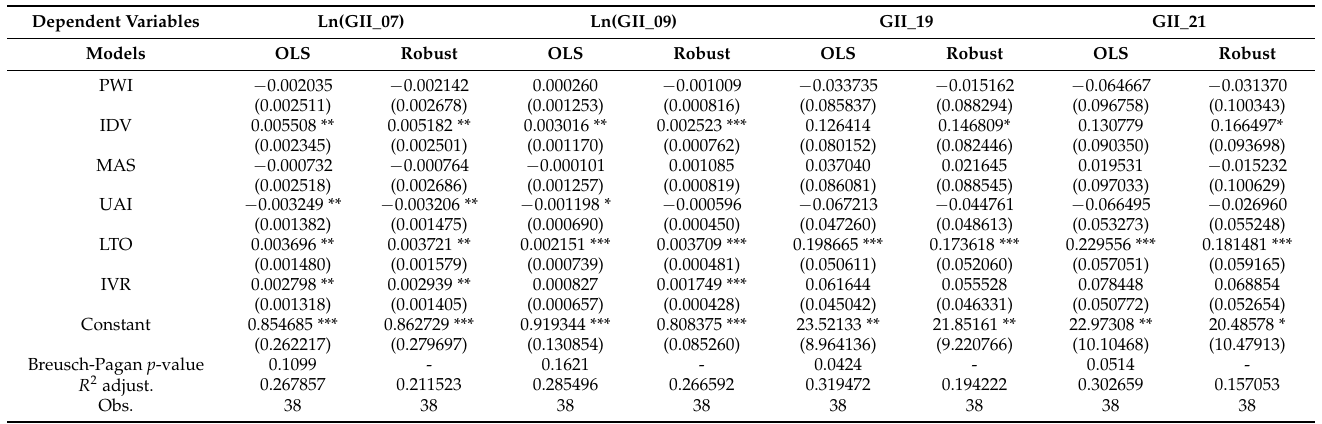
Table 7. A cross-sectional regression output (developing